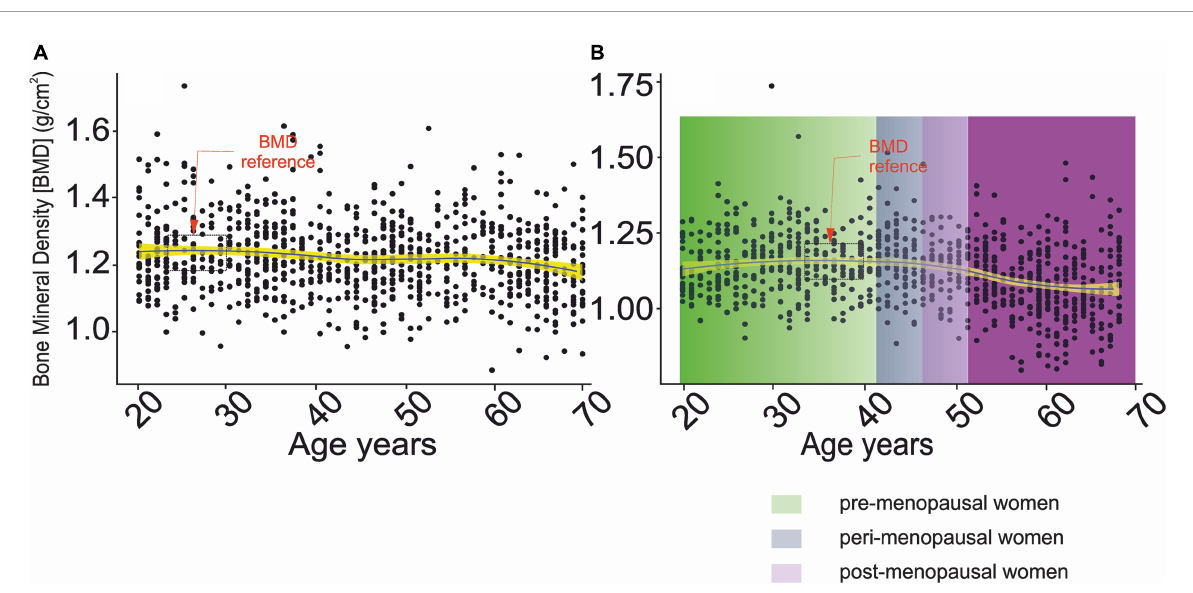
FIGURE2 Changes in bone mineral density as a function of chronological age. (A) Men, (B) women. – denotes confidence interval for the mean, , , and correspond to pre-, peri- and post-menopausal period (58).